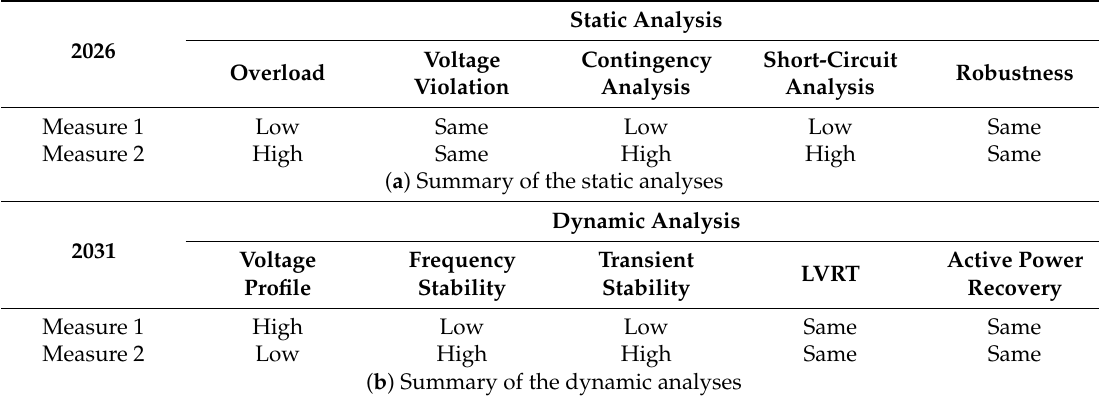
Table 22. Summary of the static and dynamic analyses after reinforcement.